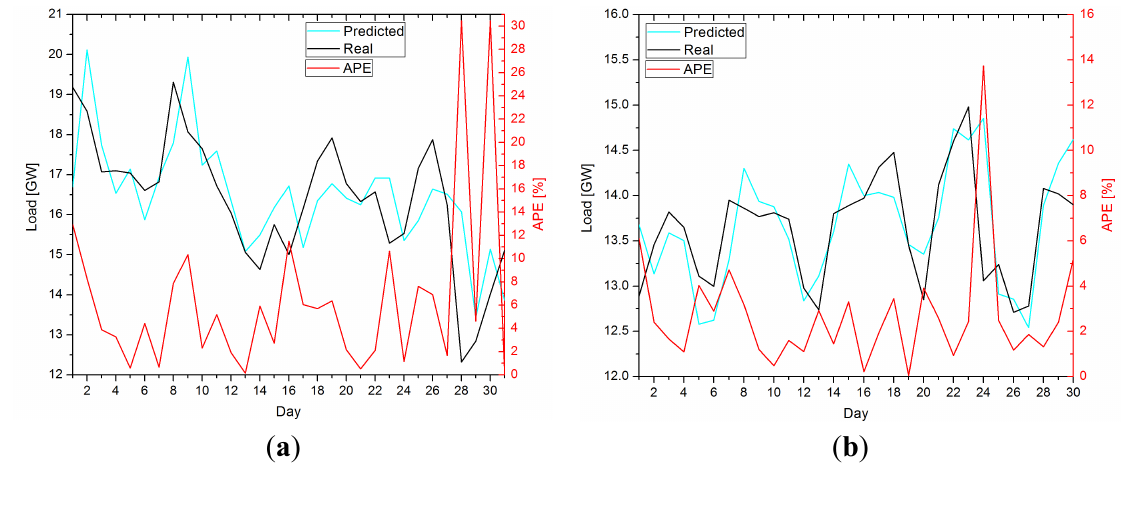
Figure 6. Real and predicted average daily load with APE. ( a ) August 2011; ( b ) November 2011; ( c ) February 2012; ( d ) May